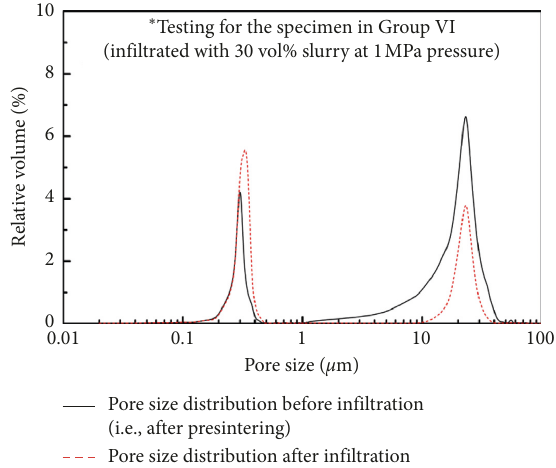
Figure 14: Pore size distribution before and after infiltration (an example of the specimens in Group